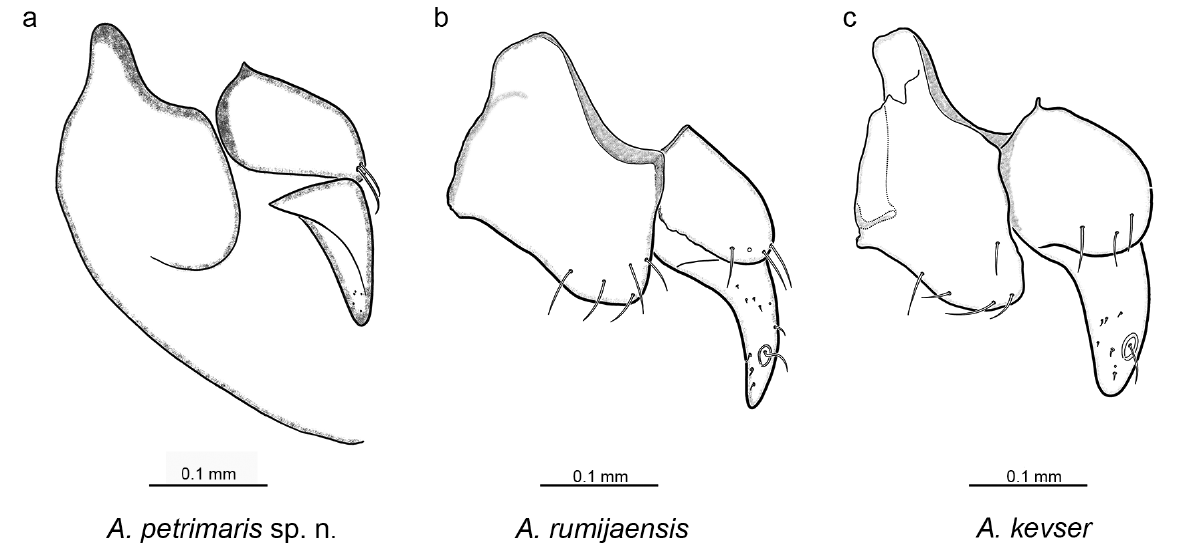
Figure 9. Female genitalia; gonocoxite 1 and 2 (basal and apical segments of gonostylus) of Adriaphaenops petrimaris sp. n. (a) , A. rumijaensis (b) , and A. kevser (c) (illustrations by Fedor Čiampor).